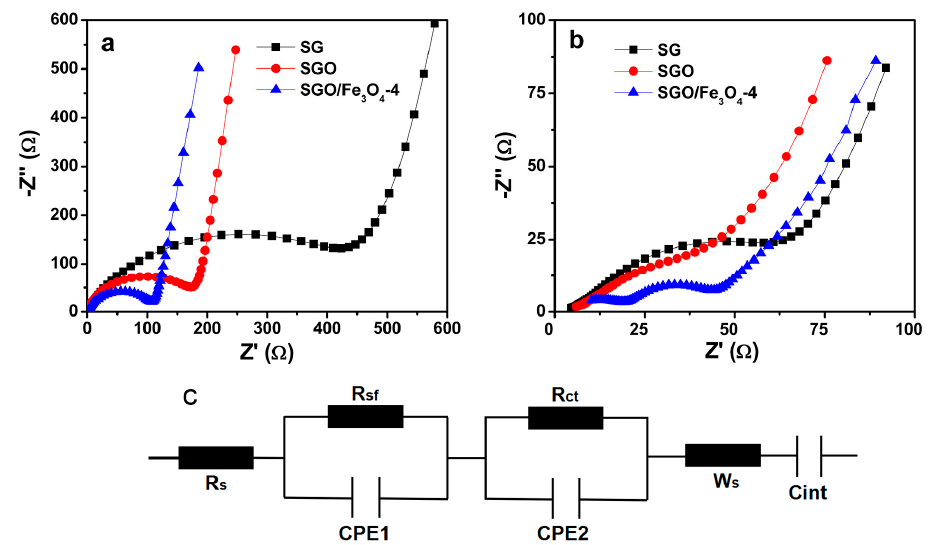
Figure 6. Nyquist plots of three samples: ( a ) fresh electrodes, ( b ) cycled electrodes, and ( c ) equivalent circuit diagram for Nyquist plots.